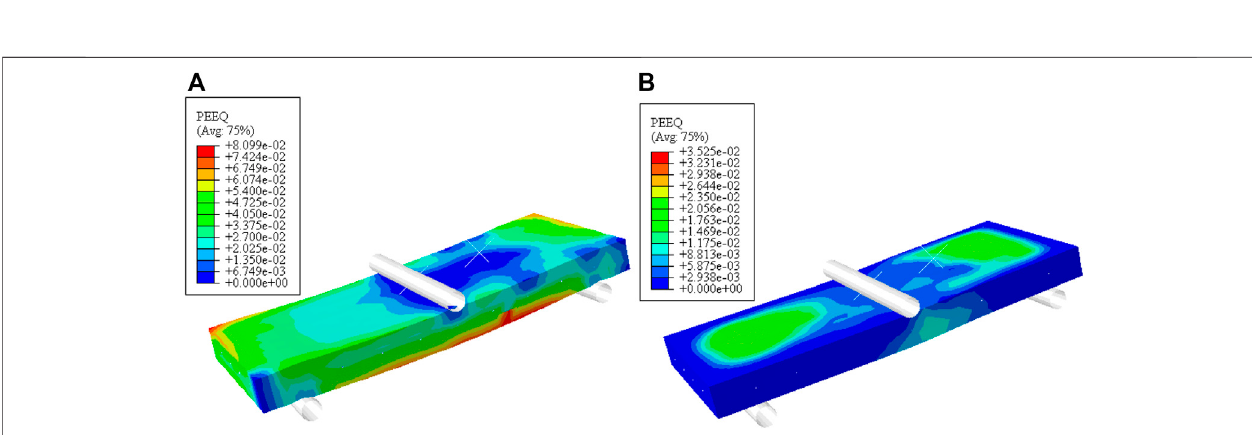
FIGURE 16 | Plastic deformation of concrete slabs under load: (A) plastic deformation of the reinforced concrete slab; (B) plastic deformation of C-shaped steel wrapped concrete slab.